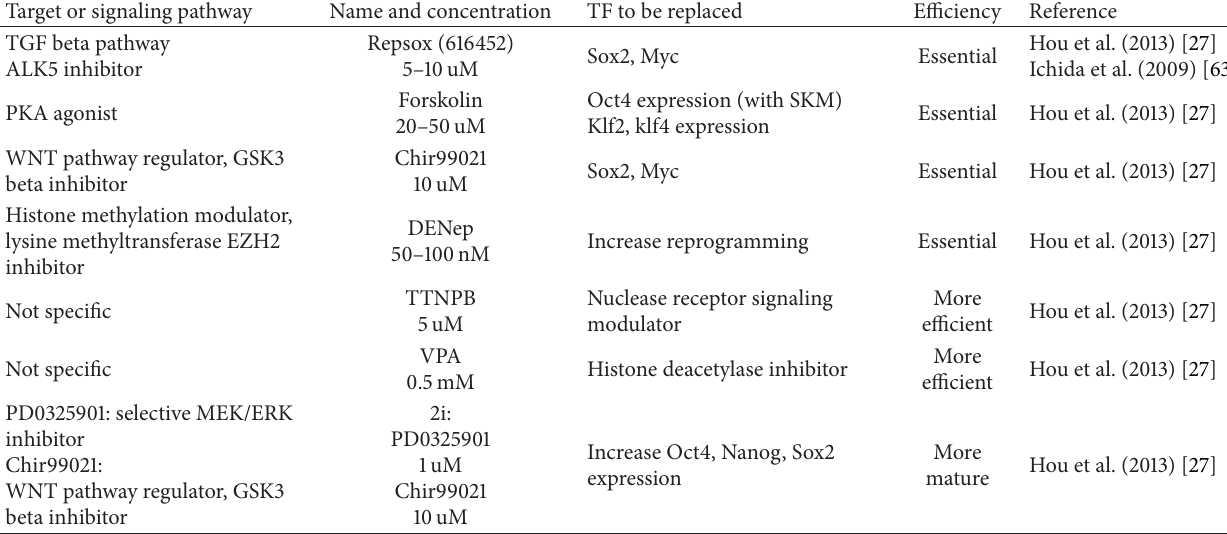
Table 3: Small molecules (VC6TFZ and 2i) that are used in mouse